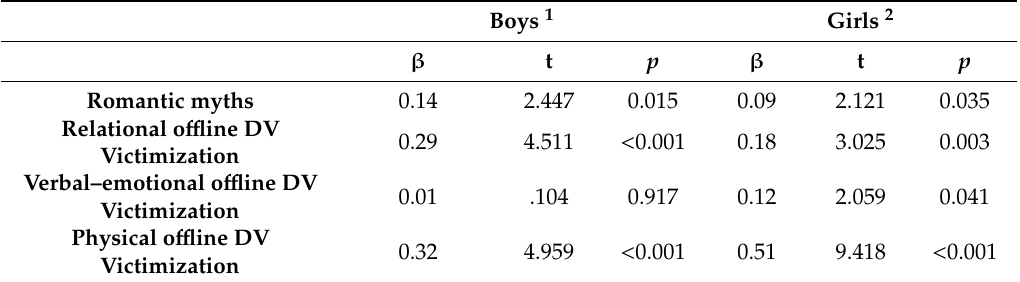
Table 4. Linear regression analysis for predicting Cyber-aggression